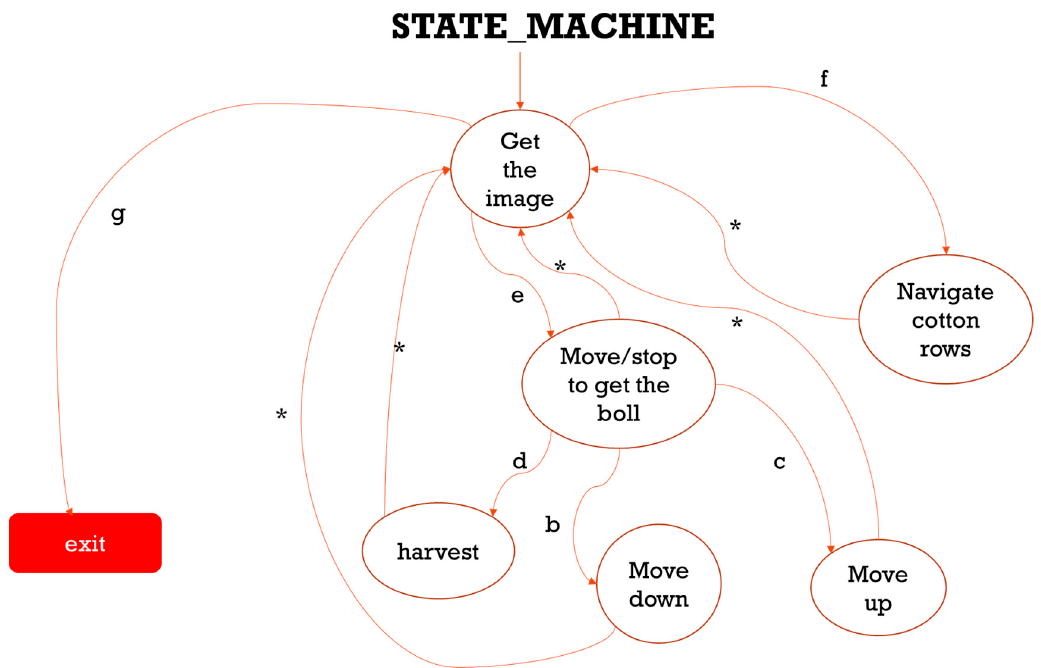
Figure 13. Finite state machine diagram of the rover states and transitions. * Means a return instruction to get a new image.